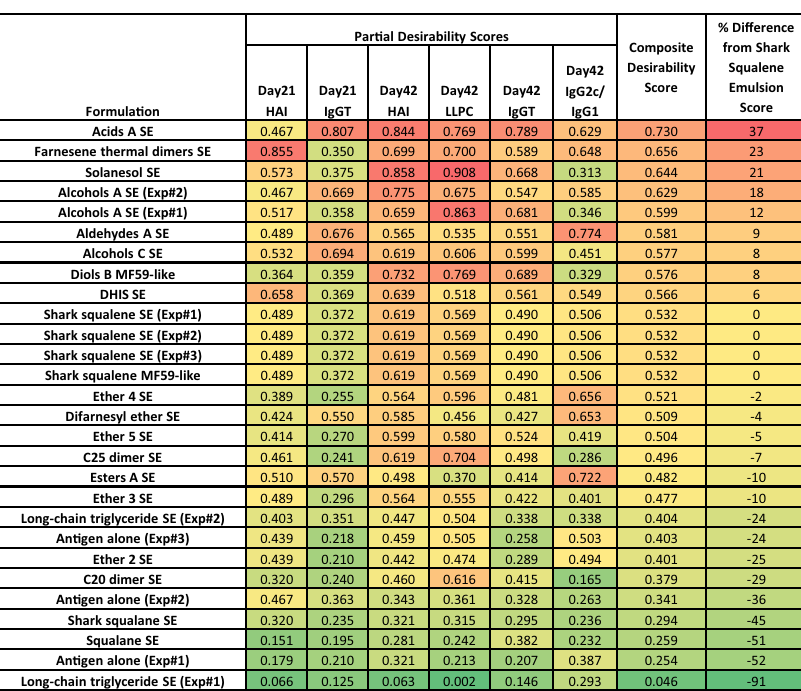
Fig. 4 Desirability index scores calculated from mouse immunogenicity studies. Values are colored from green to red to represent low to high scores. Experiment (Exp) number is provided for terpenoid emulsions evaluated in more than one mouse experiment. Abbreviations: HAI hemagglutination inhibition titer, IgGT total antigen-speci fi c serum immunoglobulin G, LLPC long-lived antibody-secreting plasma